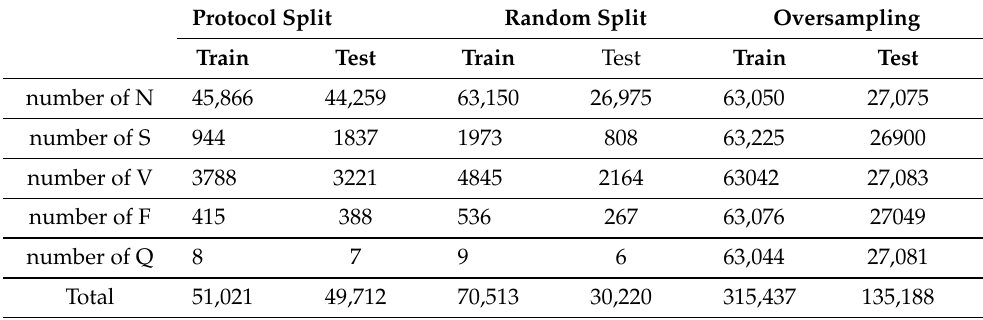
Table 6. Splitting the